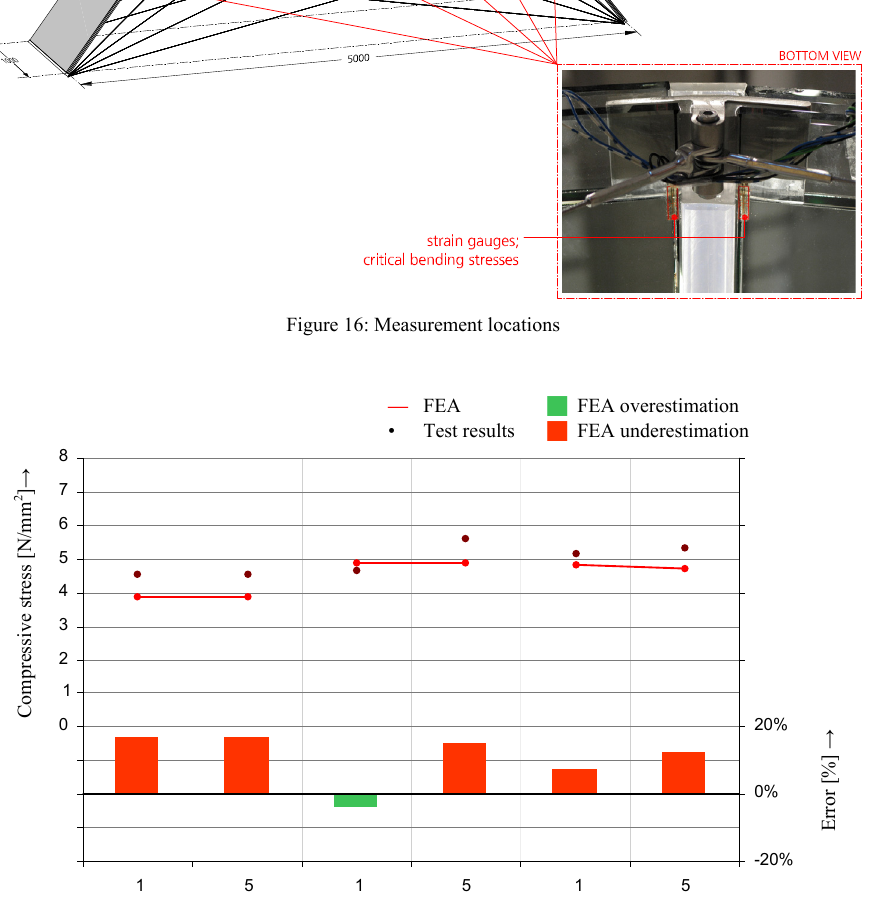
Figure 17: Compressive stresses at expected critical